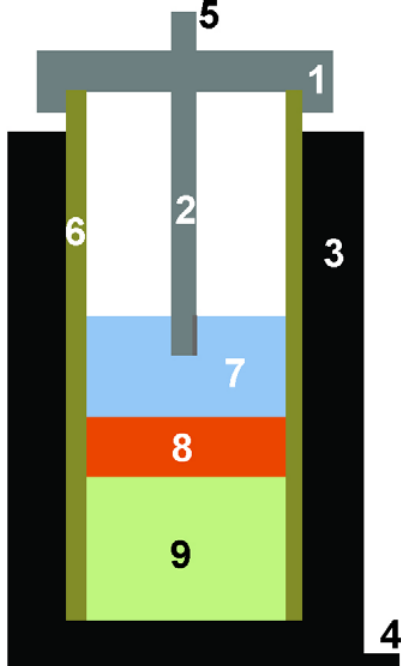
Figure 1. Scheme of liquid battery cell constructed and used in this study. 1 – stainless steel lid, 2 – graphite rod, 3 – stainless steel con- tainer, 4 – positive current collector, 5 – negative current collector, 6 – ceramic sheath, 7 – negative liquid electrode, 8 – electrolyte, 9 – positive liquid